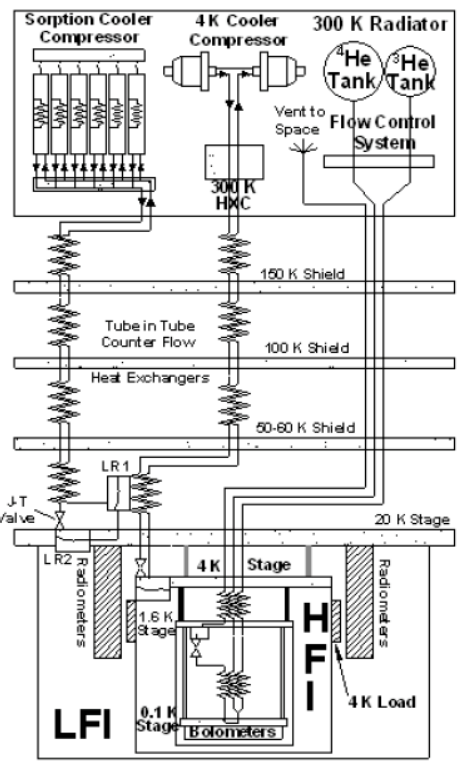
Figure 2. Schematic of the Planck cryogenic systems [13].